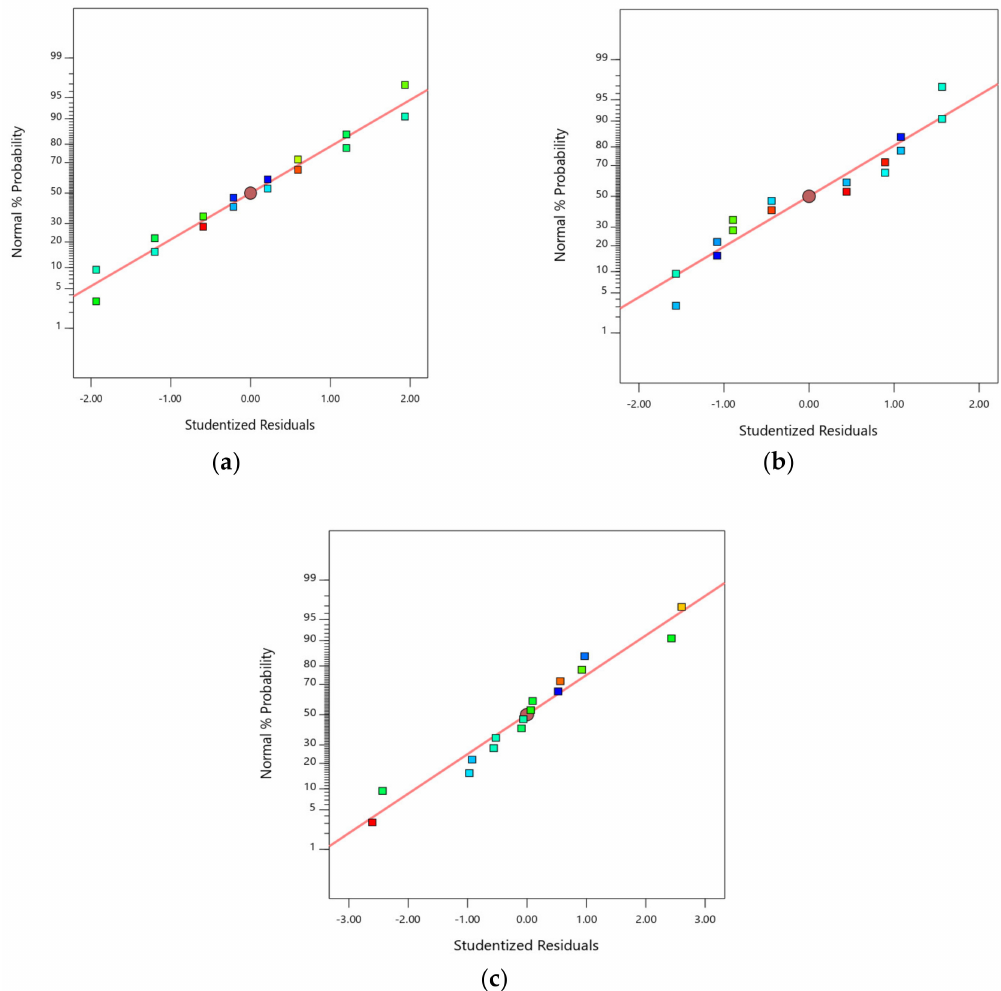
Figure 1. Normal plot of residual for ( a ) degree of hydrolysis (DH), ( b ) 2,2-diphenyl-1-picrylhydrazyl (DPPH) radical scavenging activity and ( c ) ferric-reducing antioxidant power (FRAP)